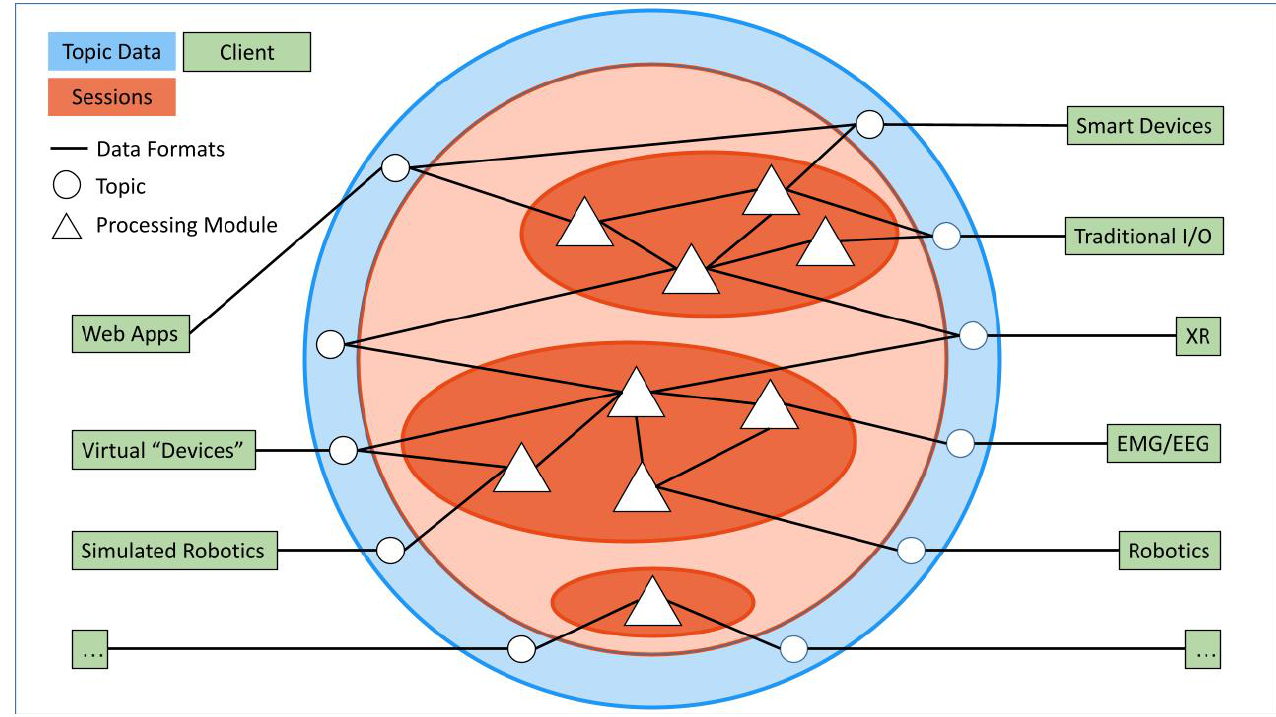
Figure 1. Ubi-Interact overview, topic data and sessions. An overview of the system with the outer layer (blue) representing network communication and the inner circle (red) representing modular processing. Boxes on the outer left and right indicate clients or their representative